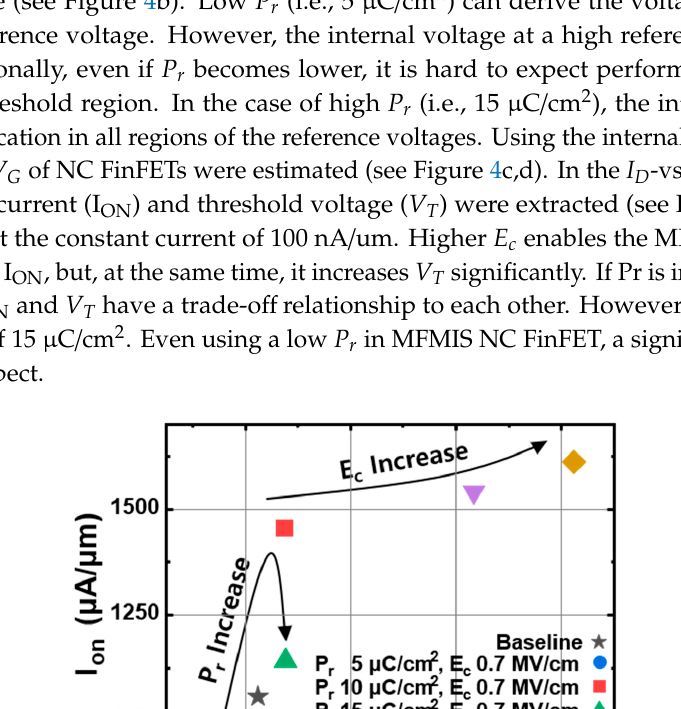
Figure 5. Scatter plot of extracted I ON and V T of various MFMIS NC FinFETs.